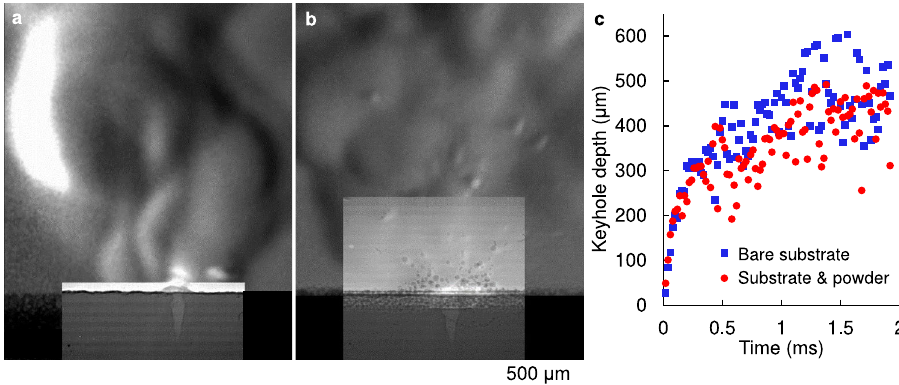
Fig. 8 Comparison of laser-material interaction at high power. Composite images of keyhole and plume ( a ) without and ( b ) with powder under 3.7 MW cm − 2 laser power density ( P = 204 W and d = 84 µ m). Both cases were qualitatively similar, with a high drill rate resulting in the formation of an unstable keyhole. The penetration depth ( c ) was consistently lower for the powder case, due to a more dynamic upper keyhole as well as laser-particle interactions. A video with the images used in this fi gure is available in the supplementary